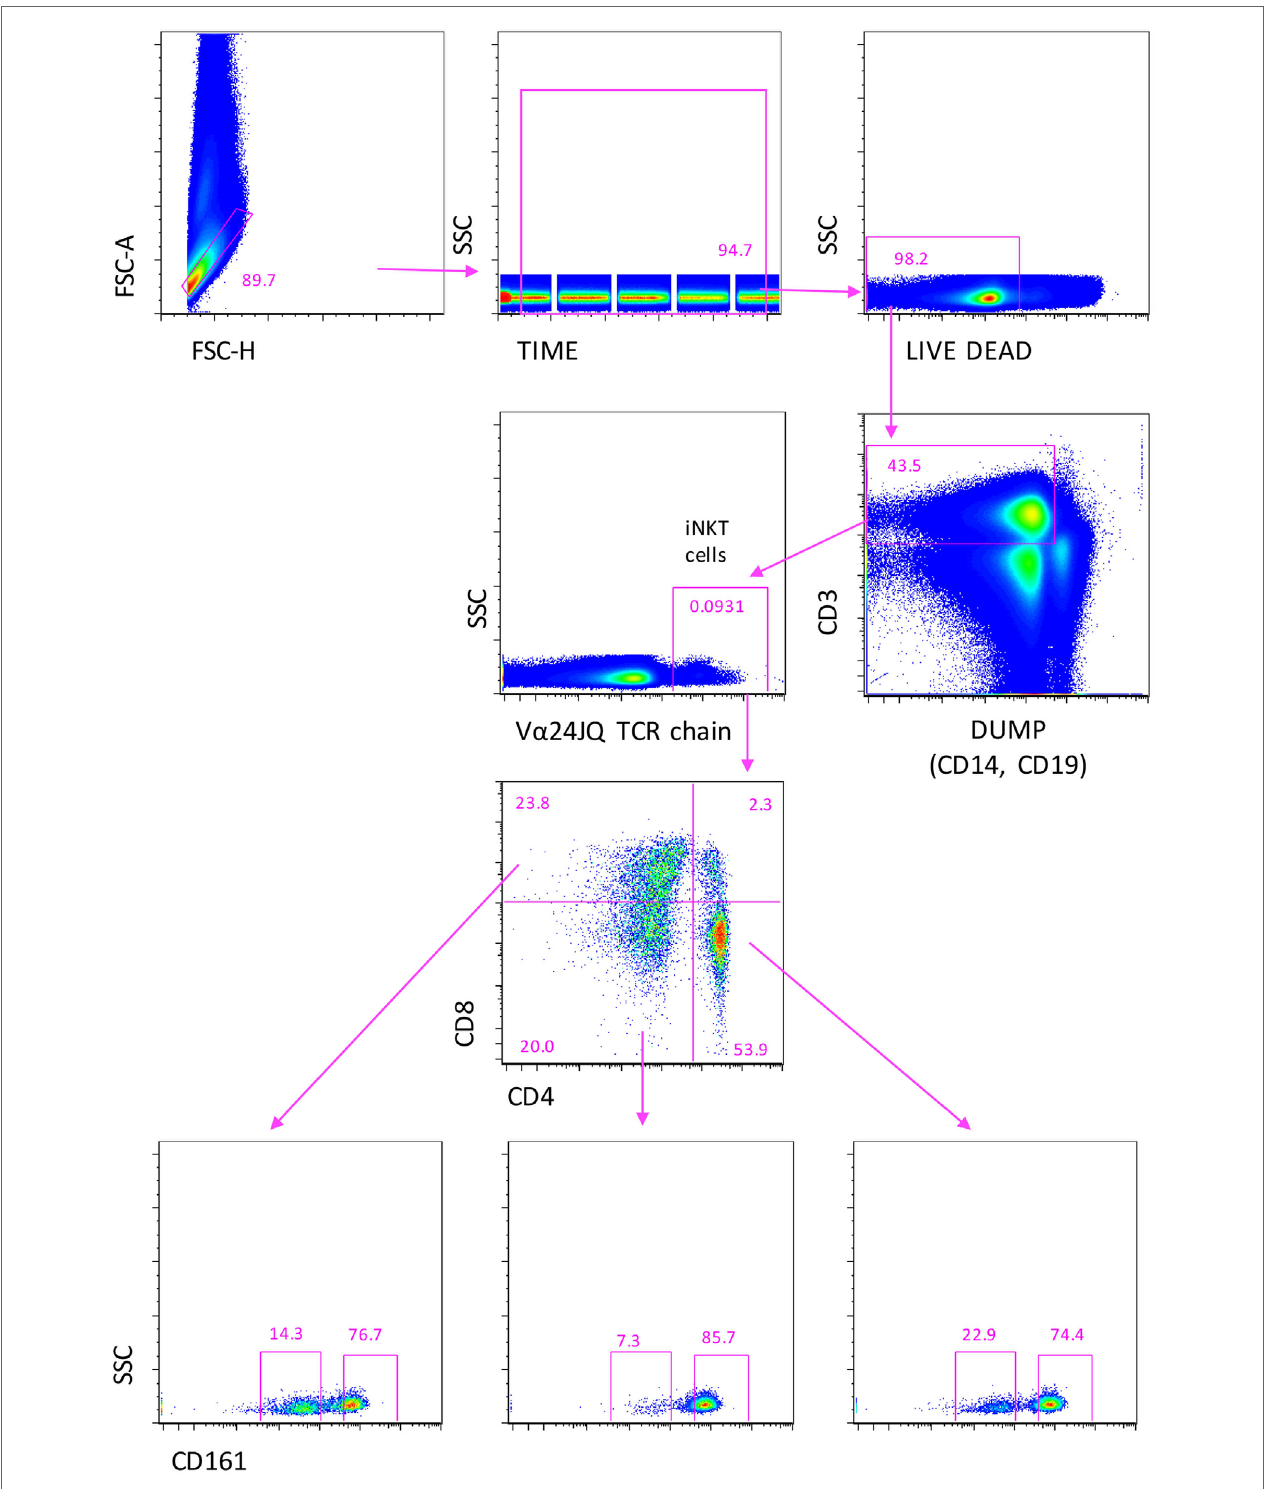
FigUre 1 | gating strategy to identify inKT cells expressing cD4, or cD8, or double negative (Dn) cells . A first gate was set on FCS-height vs. FCS-area to eliminate doublets and aggregates, the on “time of acquisition,” then, on living cell, according to negativity to live–dead staining. CD3 + T lymphocytes were identified after the removal of monocytes (CD14 + ) and B cells (CD19 + ), recognized in the DUMP channel. Then, iNKT cells were recognized according the positivity to V α 24-J α Q TCR chain. Finally, CD4 + , CD8 + , or CD4 − , CD8 − double negative (DN) iNKT were identified. In all these subsets, the expression of CD161 was evaluated. Seven color flow cytometry was used, and a minimum of 10 million events per sample were acquired using Attune NxT flow